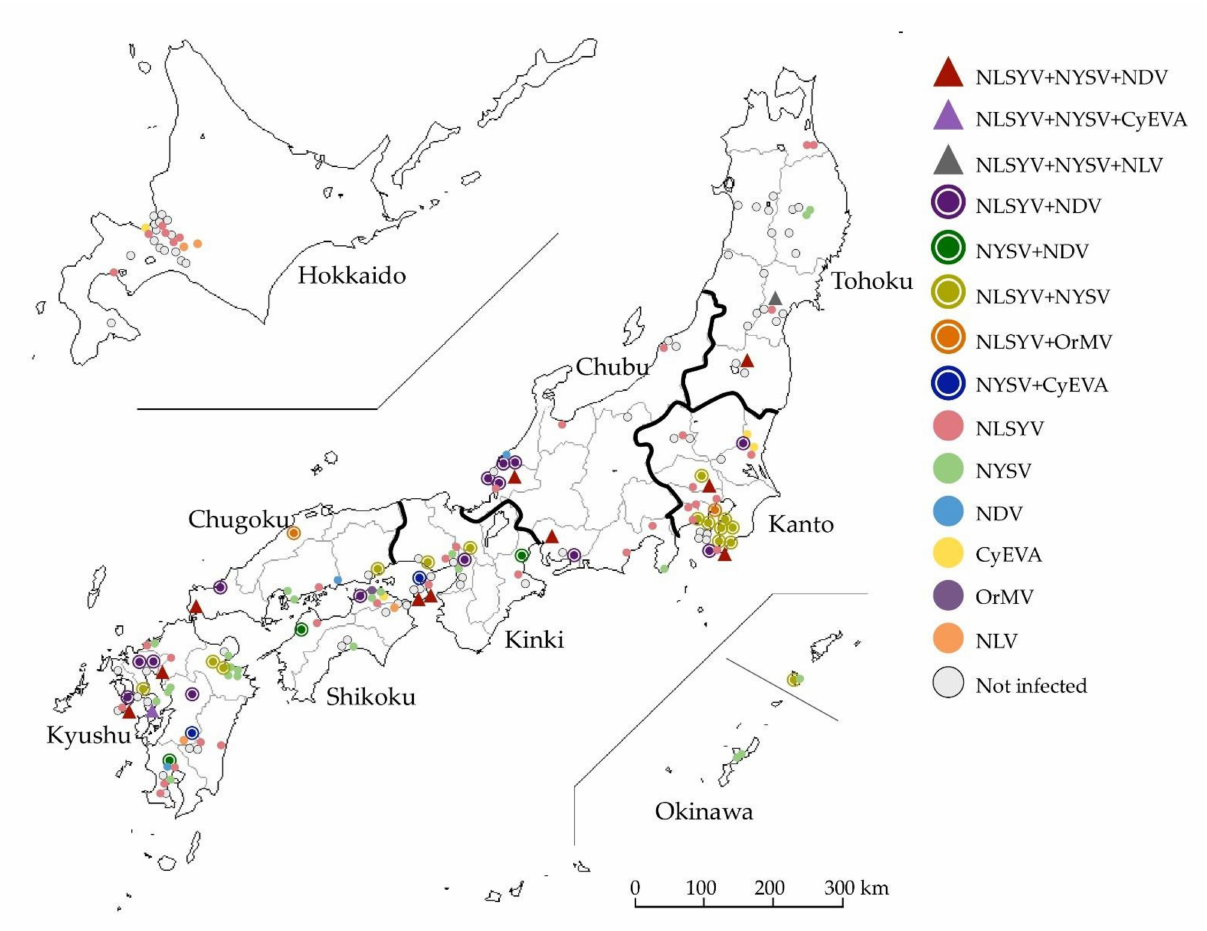
Figure 1. Collection map of wild and domesticated Narcissus plants in Japan. The Narcissus plants showing mosaic and chlorotic stripe and asymptomatic plants were collected from different sites on the banks of rivers and fields in Japan, including home gardens and flower beds, during the winter and spring seasons of 2009–2015. Color and shape of point on the map indicate the combination of detected virus, as shown in Table 1 and Table S1. Cyrtanthus elatus virus A (CyEVA), narcissus degeneration virus (NDV), narcissus late season yellows virus (NLSYV), narcissus latent virus (NLV), narcissus yellow stripe virus (NYSV), and ornithogalum mosaic virus (OrMV). The map was obtained from http://www.craftmap.box-i.net/ (accessed on 10 January